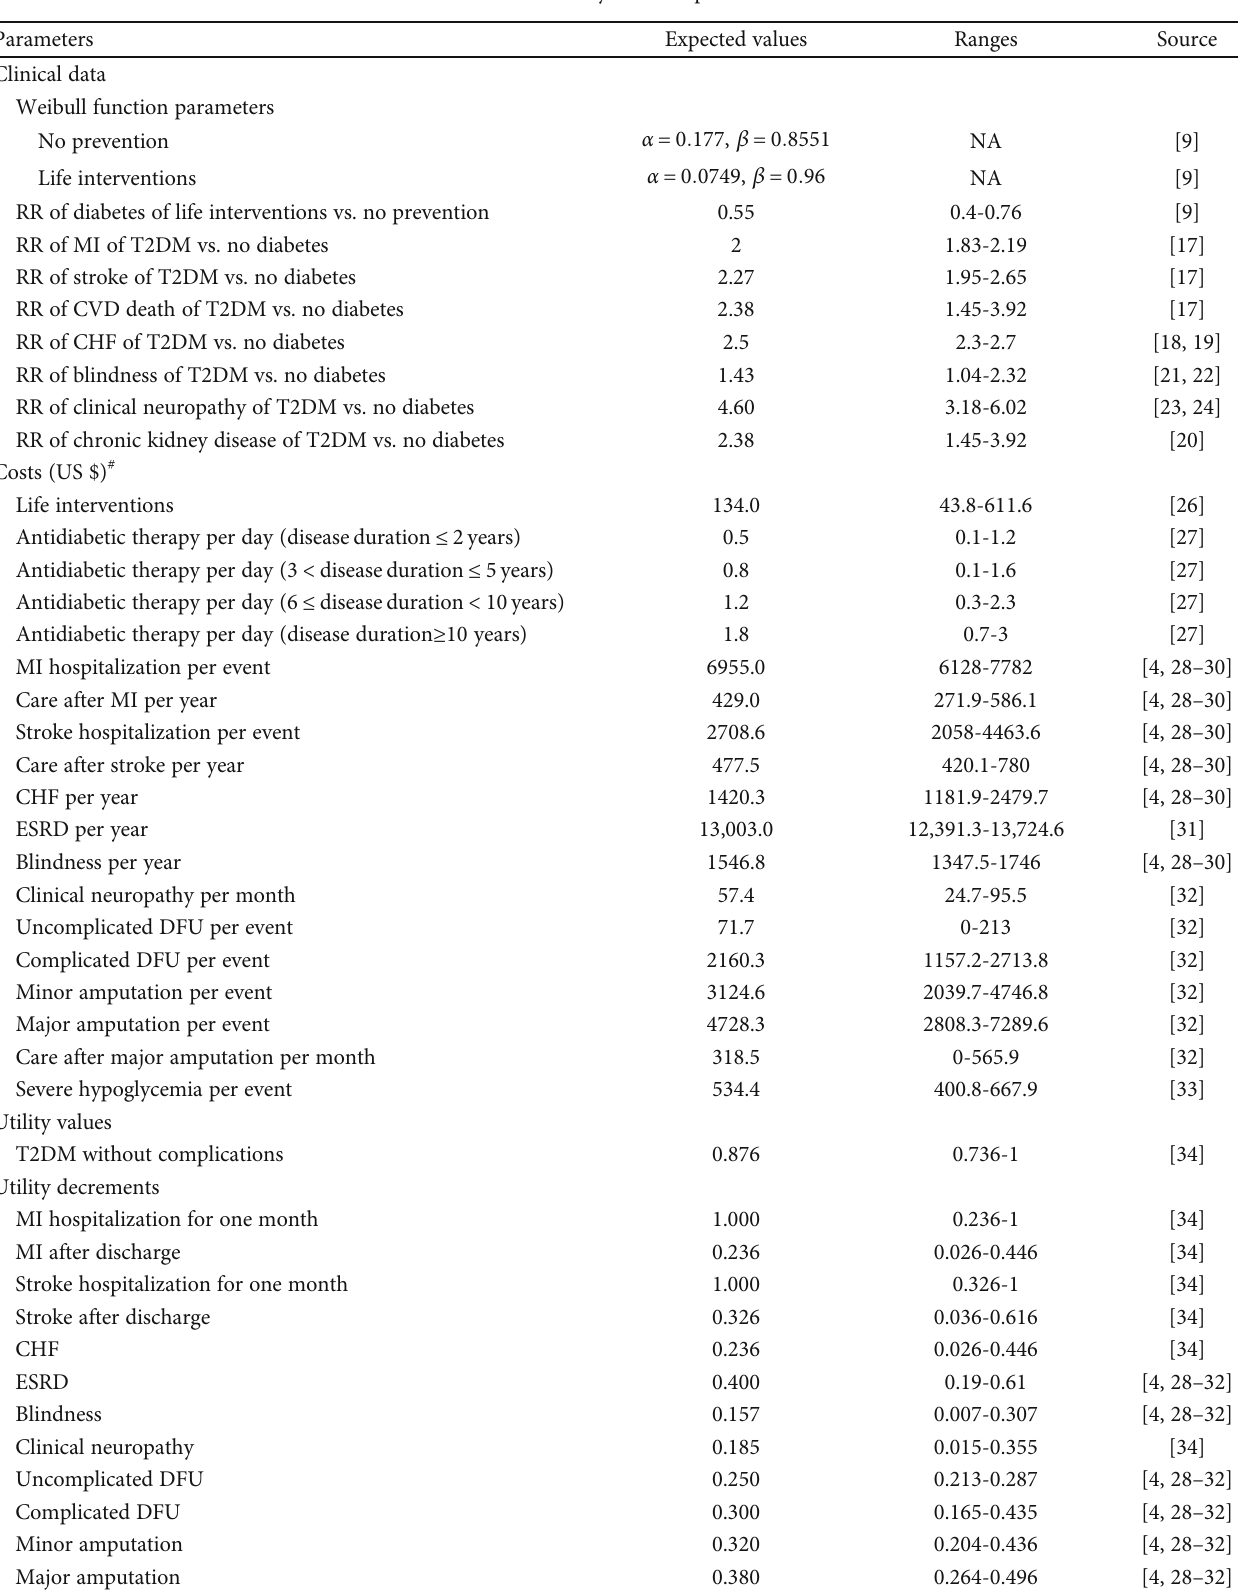
Table 1: Key model